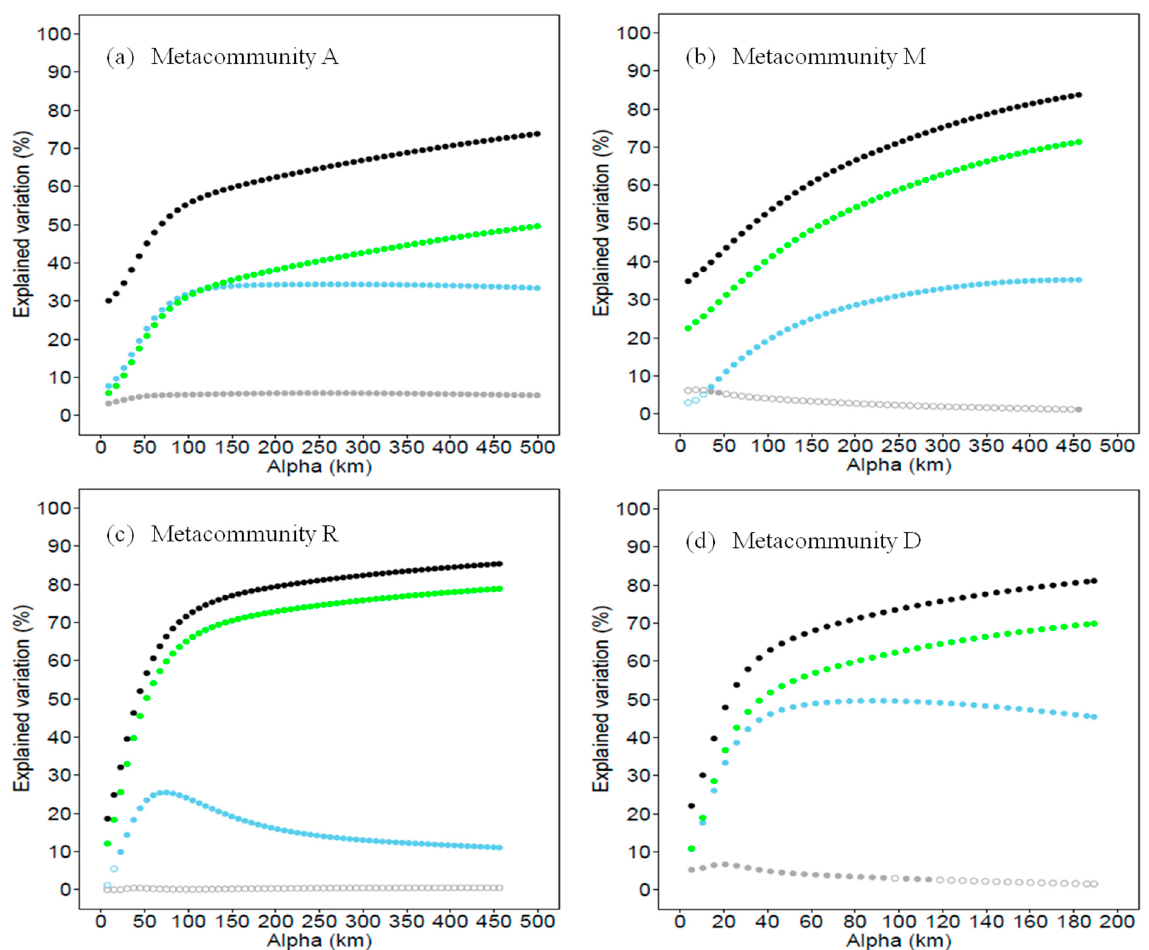
Figure 5. Changes in total explained variation (black point) and unique predictor explained variation as a function of α values in ( a ) metacommunity A (localities in the whole study area), ( b ) metacommunity M (localities in the mountain landscape), ( c ) metacommunity R (localities in the riparian landscape) and ( d ) metacommunity D (localities in the desert landscape). Due to the correlation with connectivity predictor (green points), the unique contributions of space (blue points) and environment (grey points) are also affected by α values. Solid points indicate the contribution is significant ( p < 0.05, Monte Carlo permutest) and circles indicate contributions that are not significant.